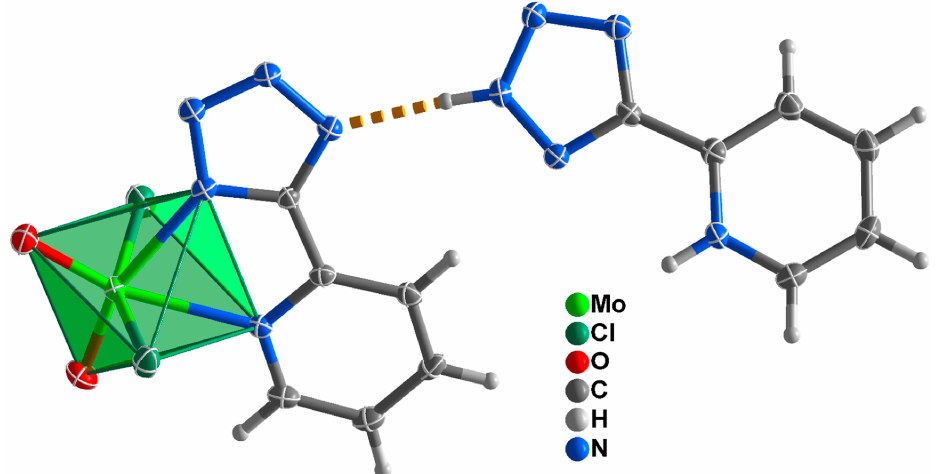
Figure 2. Schematic representation of the asymmetric unit of compound 1 , emphasizing the inter- molecular hydrogen bond between the anionic metal complex and the neighboring H 2 pytz + cation (dashed orange line). Atomic labelling has been omitted for clarity. Selected bond lengths (Å) and angles ( ◦ ) for the Mo VI coordination environment: Mo1—O1 1.692(2), Mo1—O2 1.691(2), Mo1—N1 2.377(2), Mo1—N2 2.286(2), Mo1—Cl1 2.3729(9), Mo1—Cl2 2.3685(9), O2—Mo1—O1 106.09(11), N2—Mo1—N1 69.38(10), Cl2—Mo1—Cl1